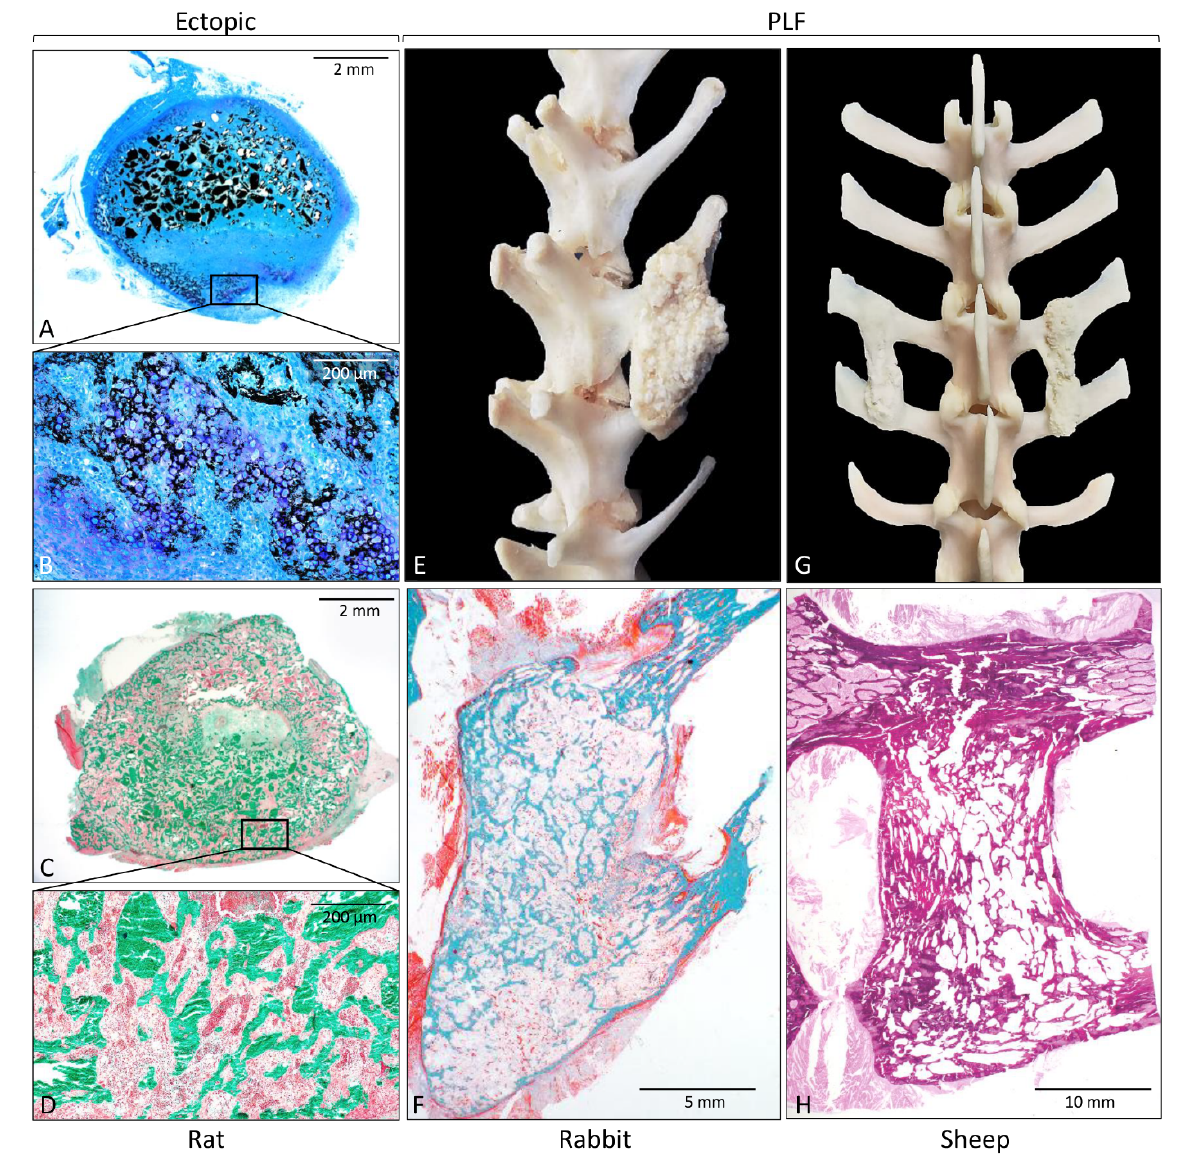
Figure 2. Histological sections and gross anatomy of newly formed bone induced by rhBMP6 in a rat subcutaneous assay ( A – D ); rabbit ( E , F ) and sheep ( G , H ) posterolateral spinal fusion model. ( A , B ) On day 7 following implantation, endochondral bone formation occurs at the peripheral site of ABGS, while 14 days ( C , D ) after implantation, newly formed bone is present throughout the implant containing rhBMP6 lyophilized on allograft mixed with ABC. Gross anatomy of newly formed bone between transverse processes in rabbit ( E ) and sheep ( G ) PLF model. Histological sections through fusion mass in rabbit ( F ) and sheep ( H ) PLF model. Histological sections were processed undecalcified and stained by Von Kossa ( A , B ), Goldner ( C , D , F ), and hematoxylin and eosin ( H ). (Modified from [74,88], respectively.)